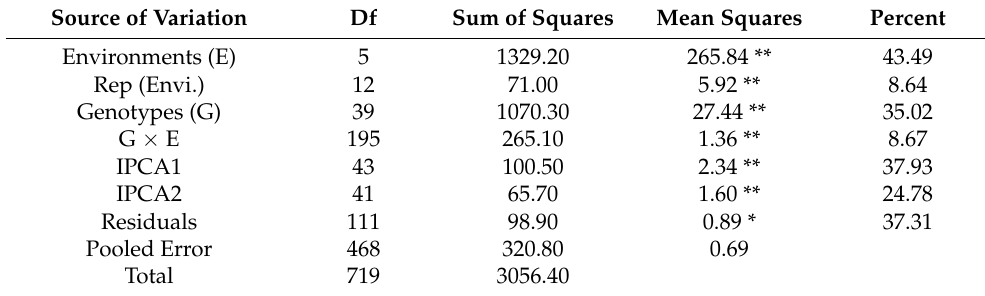
Table 7. AMMI analysis of grain yield (ton ha − 1 ) variance of 40 maize hybrids across six agro-environments.